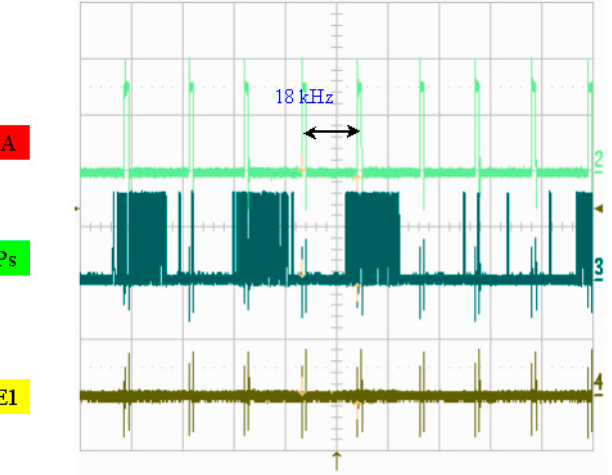
Figure 10. Frequency testing: normal mode.